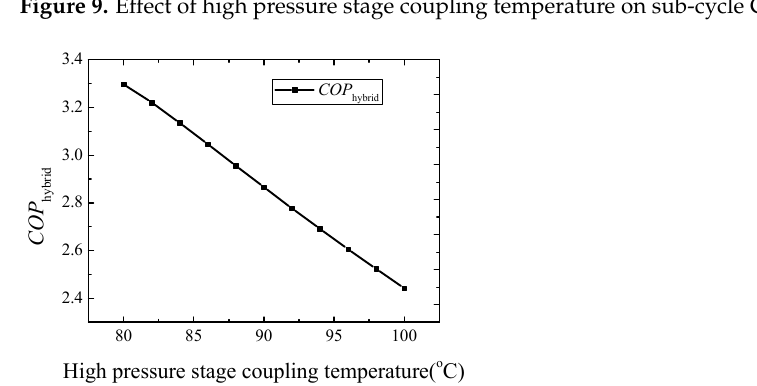
Figure 10. Effect of high pressure stage coupling temperature on coupling cycle COP.